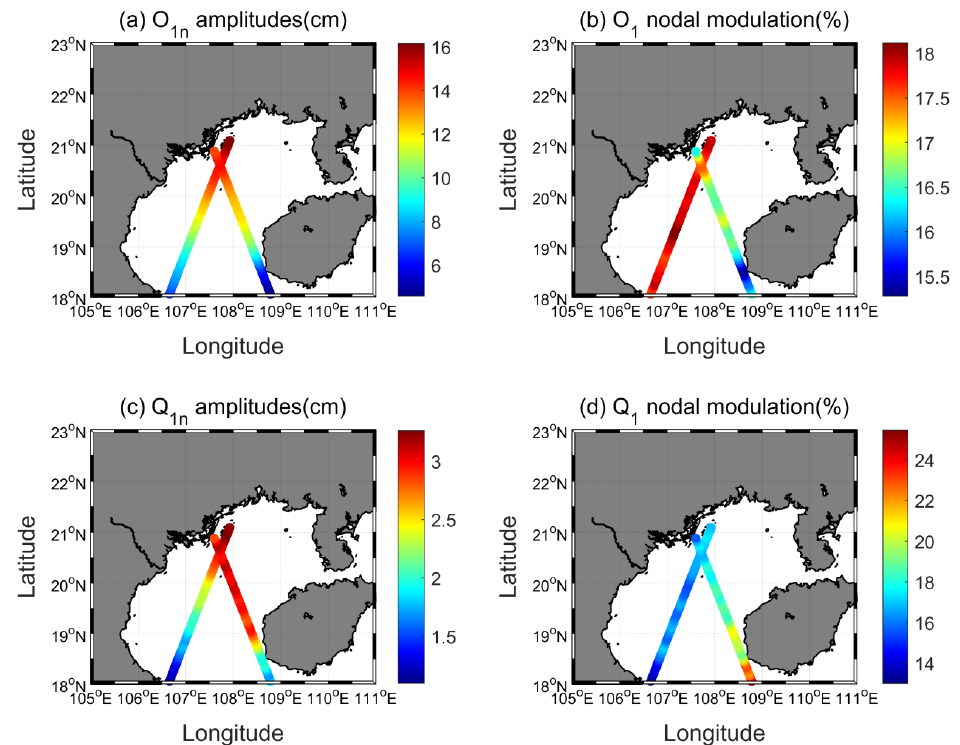
Figure 7. Estimated nodal amplitudes and nodal modulations from T/P-Jason observations in the Gulf of Tonkin: ( a ) O 1n amplitudes, ( b ) O 1 nodal modulations, ( c ) Q 1n amplitudes, ( d ) Q 1 nodal mod- ulations.